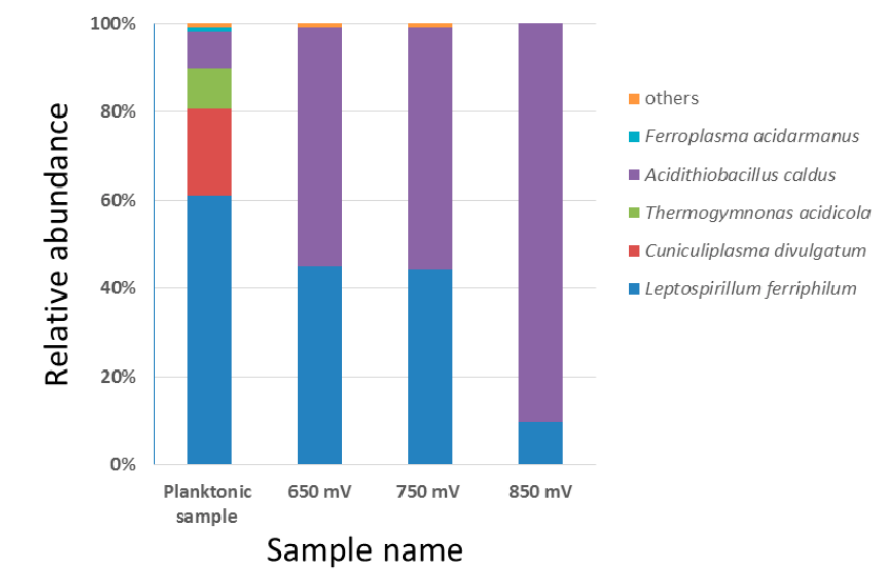
Figure 8. Relative abundance (%) of the dominant species in the planktonic sample and pyrite surface under different redox potentials. The species with a relative abundance of >1% were listed.